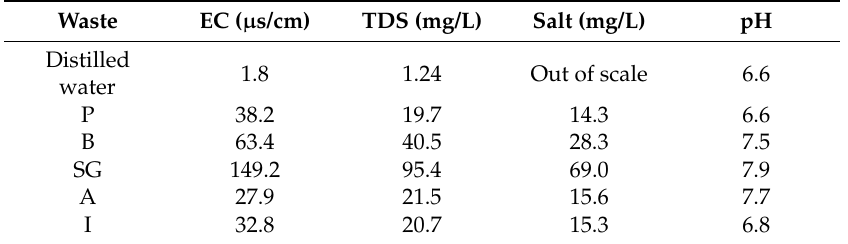
Table 2. Electrical conductivity, total of dissolved solids, salt, and pH of the different wastes.